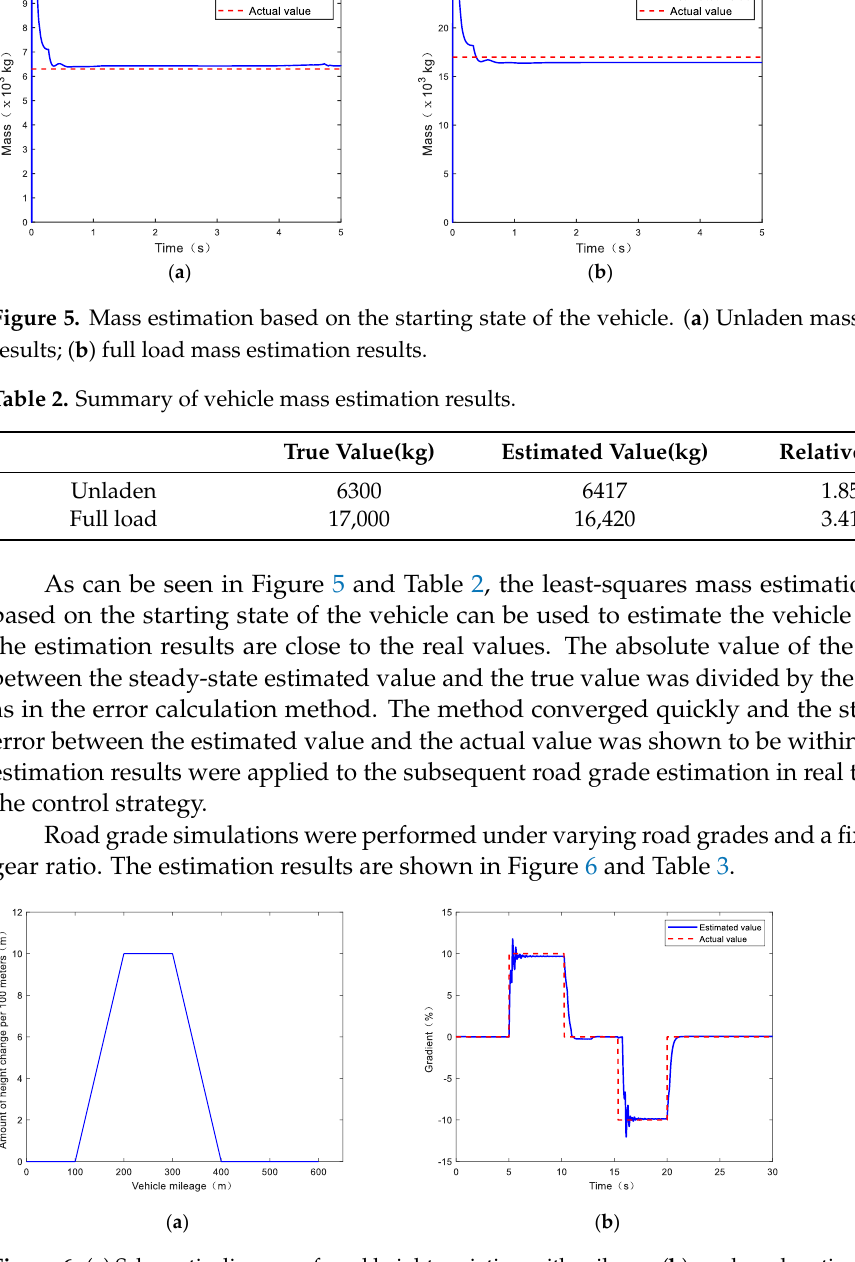
Figure 6. ( a ) Schematic diagram of road height variation with mileage; ( b ) road grade estimation results. Table 3. Road grade estimation results.